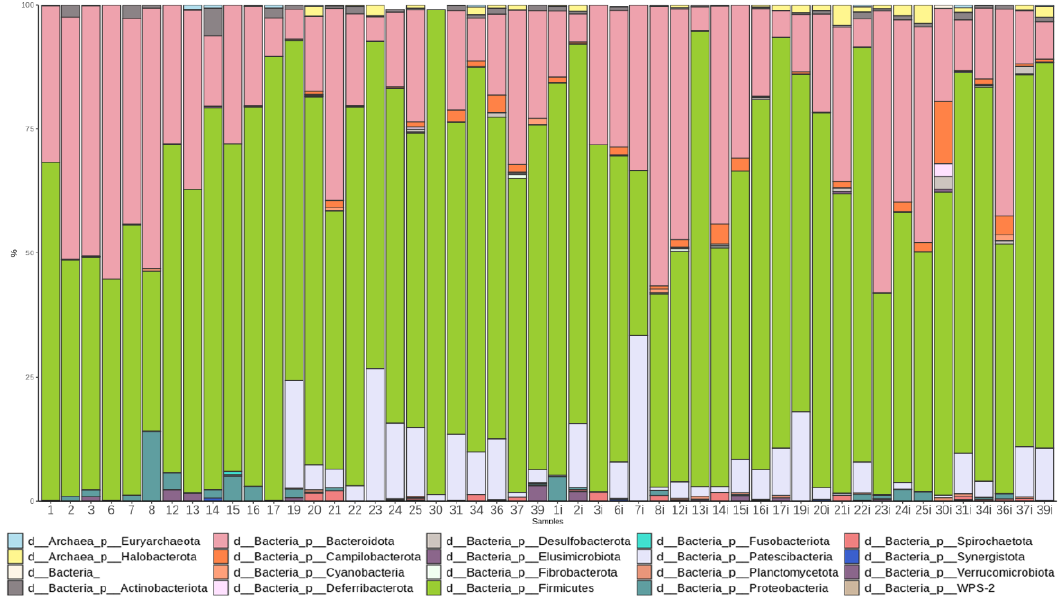
Figure 3. Abundance of the main bacterial phyla before (samples 1 through 25) and after the TBI (samples 1i through 25i).